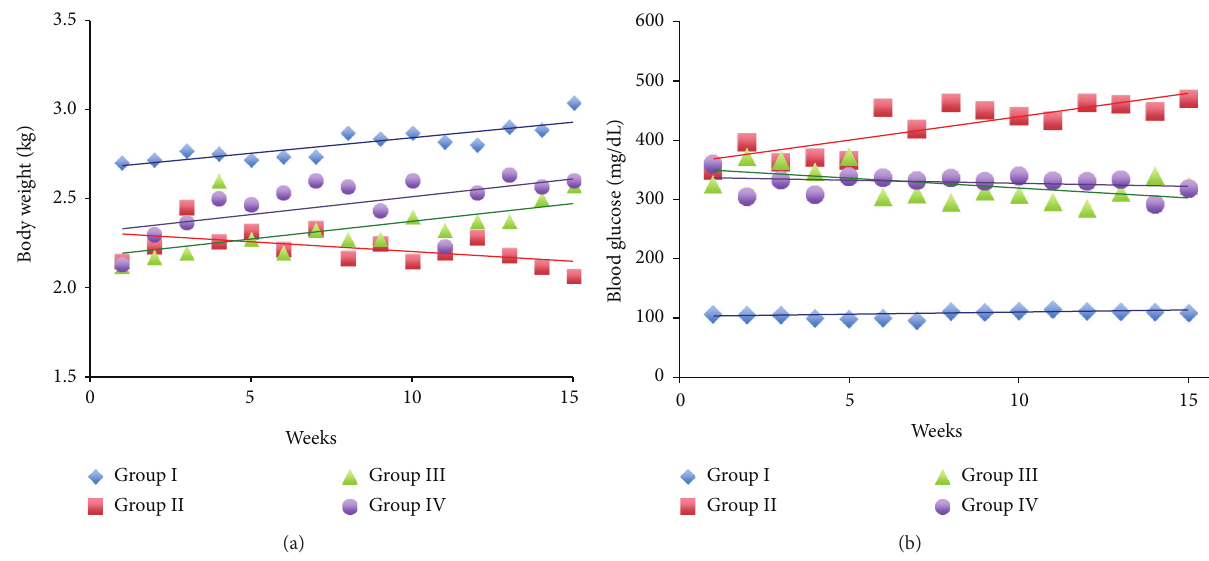
Figure 1: The effect of the taurine on body weight (a) and blood glucose levels (b) in alloxan-induced diabetic rabbits over the 15 weeks of